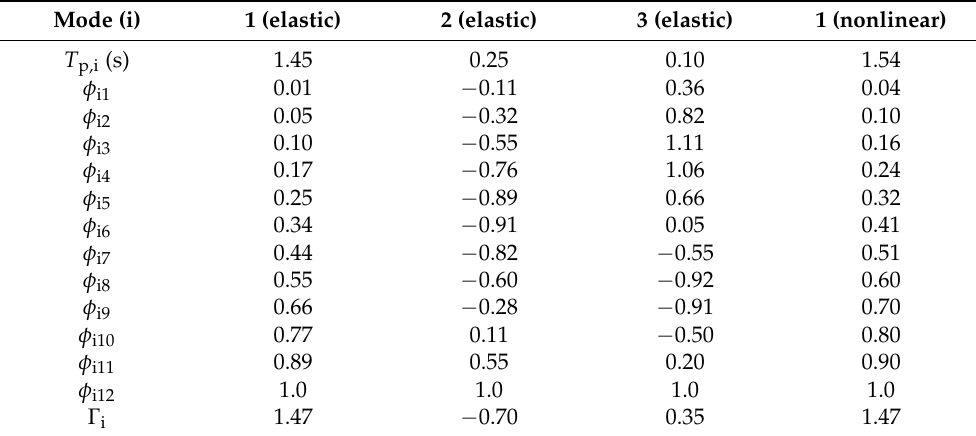
Table 2. Periods of vibration ( T p,i ), mode shapes ( φ ij ) and modal participation factors ( Γ i